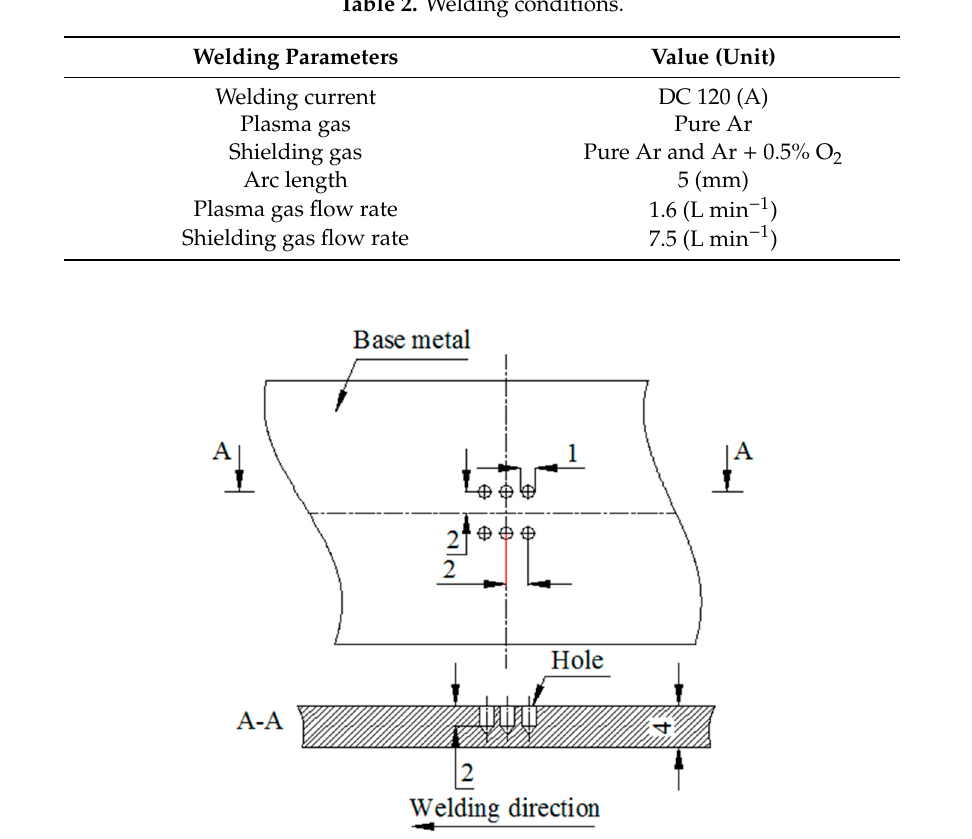
Figure 2. Schematic illustration of holes on the base metal surface.